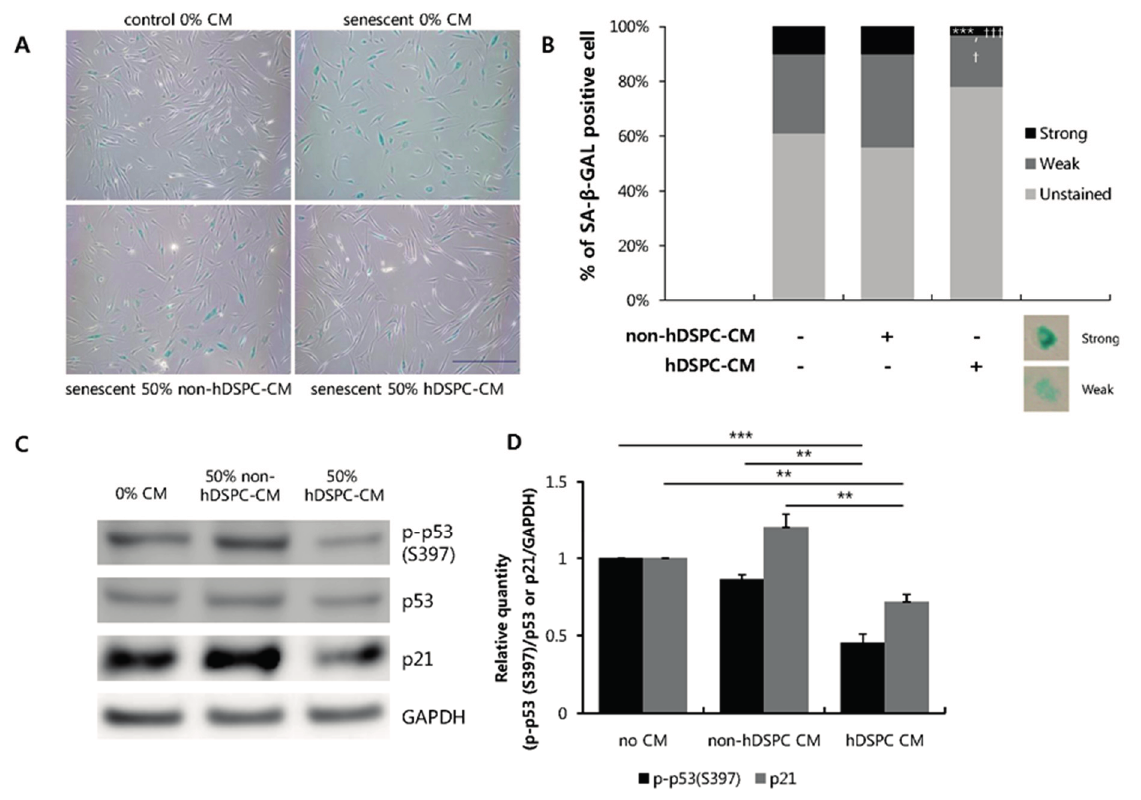
Figure 2. hDSPC-CM reduced the expression of senescence-associated markers in senescent fibroblasts. Senescent fibroblasts were incubated with either 0% or 50% of each CM for 72 h. SA- β -Gal-positive cells appeared blue when visualized with optical microscopy. The scale bar indicates 500 μ m ( A ); Quantification of SA- β -Gal-positive cells in panel A. *** p < 0.001 vs. 0% CM control; † p < 0.05, ††† p < 0.001 vs. non-hDSPC-CM group ( B ); Western blot analysis of p53 and p21 in each group of CM-treated senescent fibroblasts. The image represents three independent experiments and graphs depict means ± S.E.M. ** p < 0.01, *** p < 0.001 ( C , D ). Data were statistically compared with one-way analysis of variance ( B ) or an unpaired Student’s t -test ( D